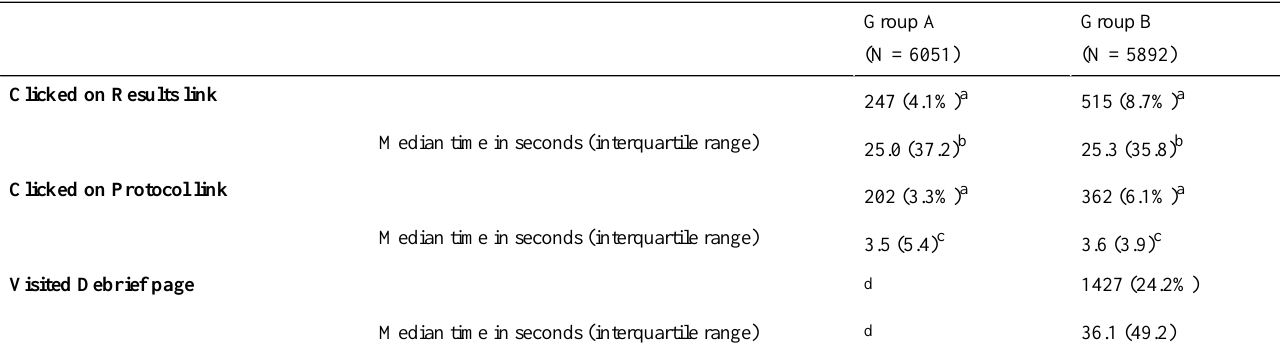
Table 1. All outcome data.